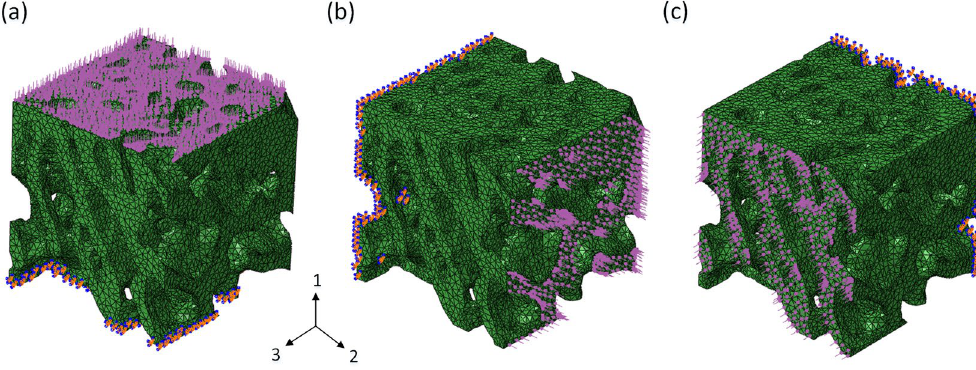
Figure 4. Statistical table of the morphological parameters of the trabecular bone in different regions of the femoral